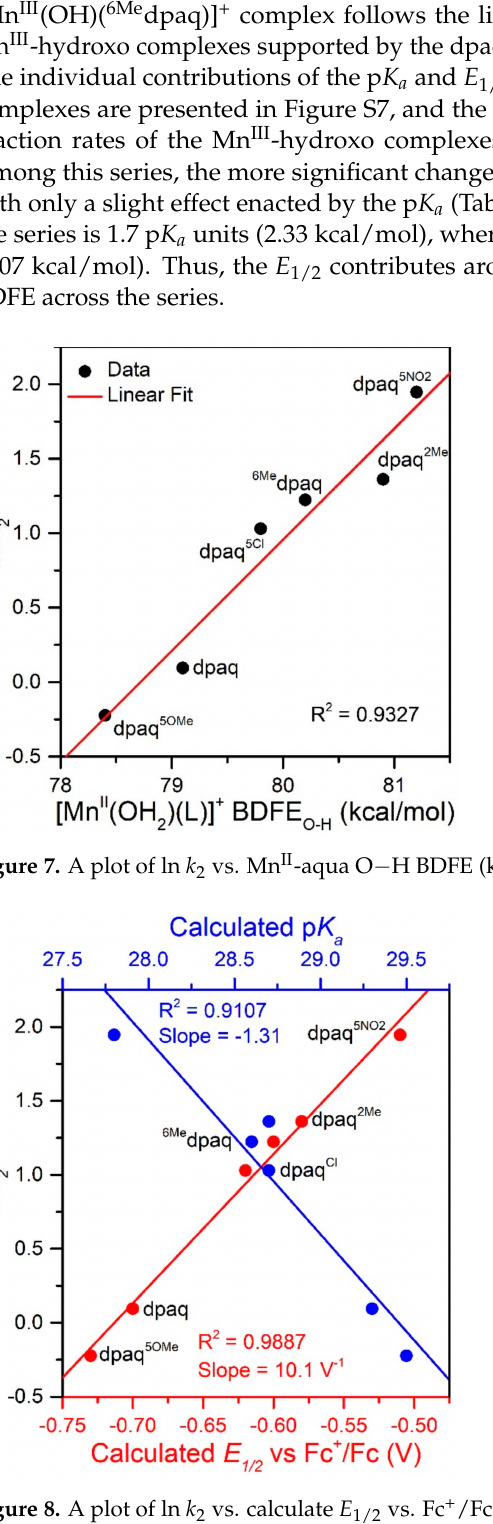
Figure 8. A plot of ln k 2 vs. calculate E 1/2 vs. Fc + /Fc (V) and p K a